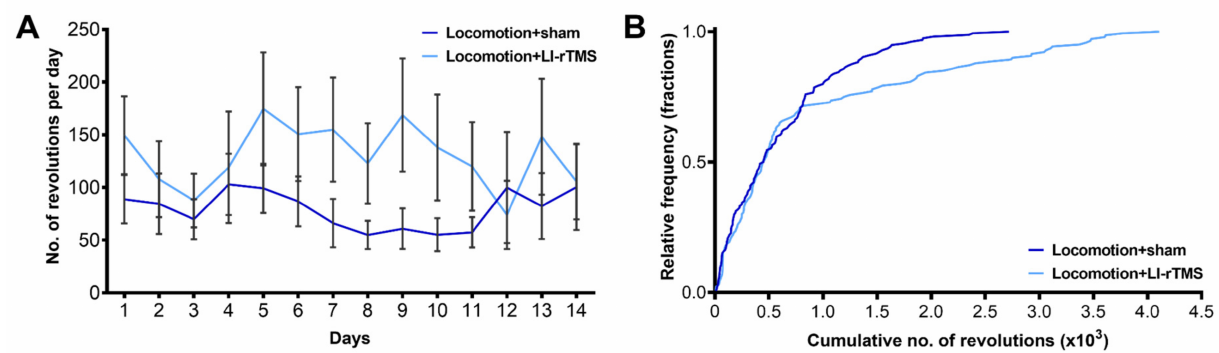
Figure 3. Online LI-rTMS did not alter the total distance ran during each session and over all sessions. Adult ephrin-A2A5 -/- mice were given free access to a running wheel during each treatment session. ( A ) Average revolutions on the running wheel per day were not different between sham or LI-rTMS treated subjects. Error bars represent SEM. ( B ) Cumulative number of running wheel revolutions over the 14